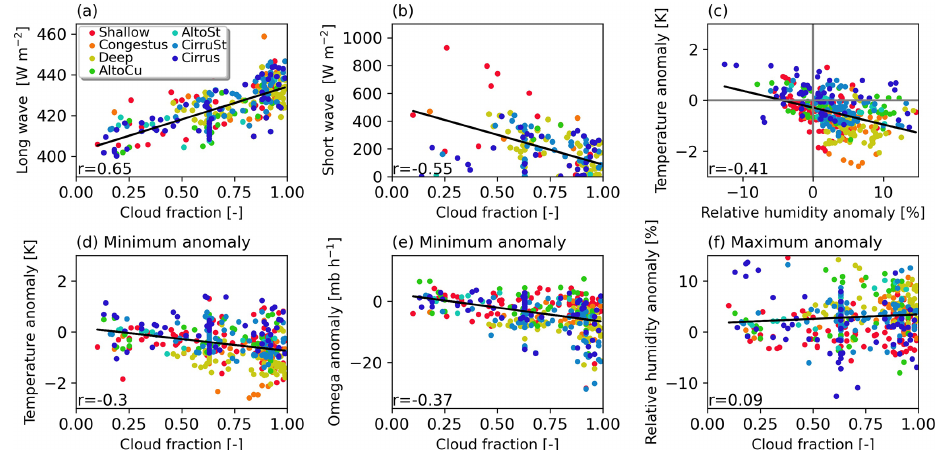
Figure 7. Scatter plot between observed cloud fraction and longwave radiation, shortwave radiation, precipitation rate, minimum values of temperature variance, minimum omega, and maximum relative humidity for selected cases during IOP1 (wet season). Each color represents a cloud type: blue (cirrus), cobalt (cirrost), teal (altost), green (altocu), yellow (deep), orange (congestus), red (shallow) and white (clear